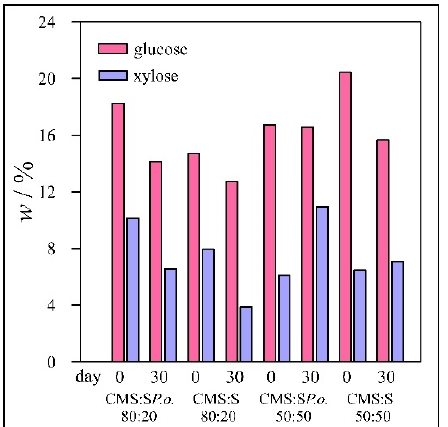
Figure 1. Concentrations of glucose and xylose in wheat straw samples.